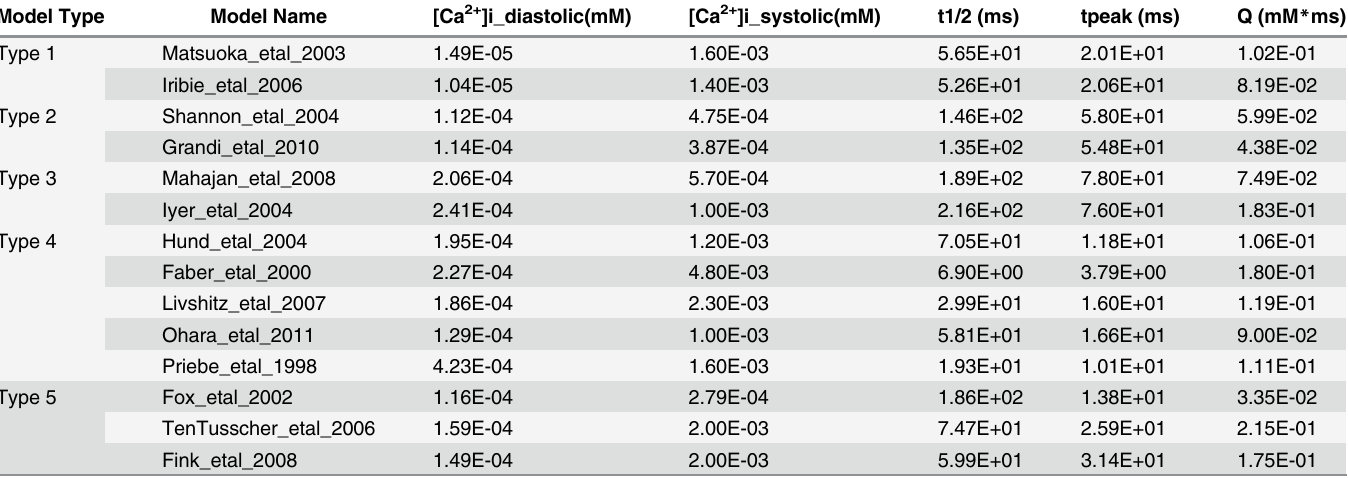
Table 6. Data for steady priming beat: models with NL96 contraction.